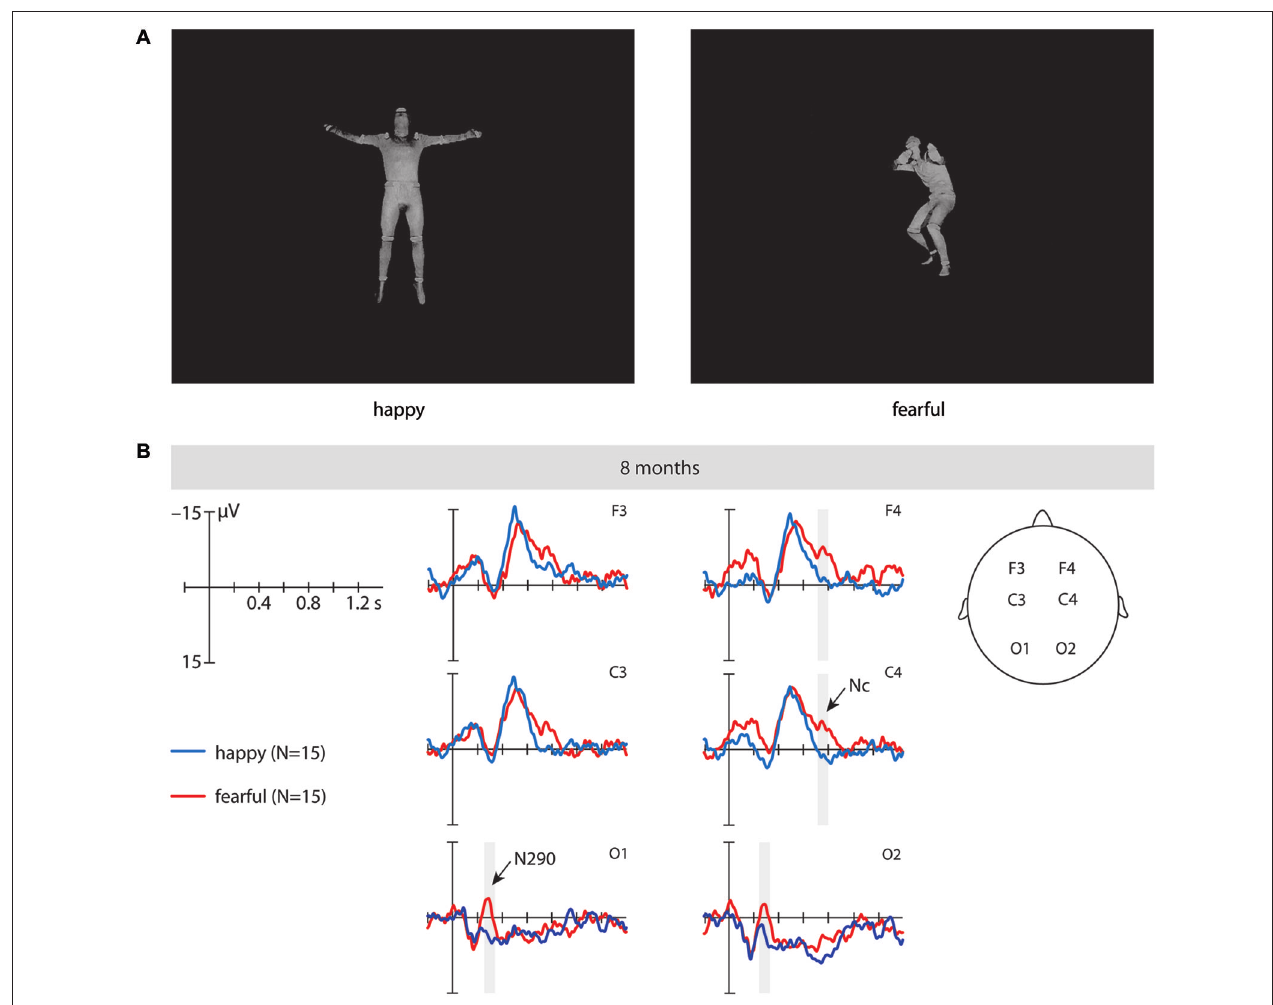
elicited by fearful upright (red) and happy upright (blue) static full-light body expressions. The time windows during which significant differences between fearful and happy body expressions were observed are marked in gray. Note that negativity is plotted